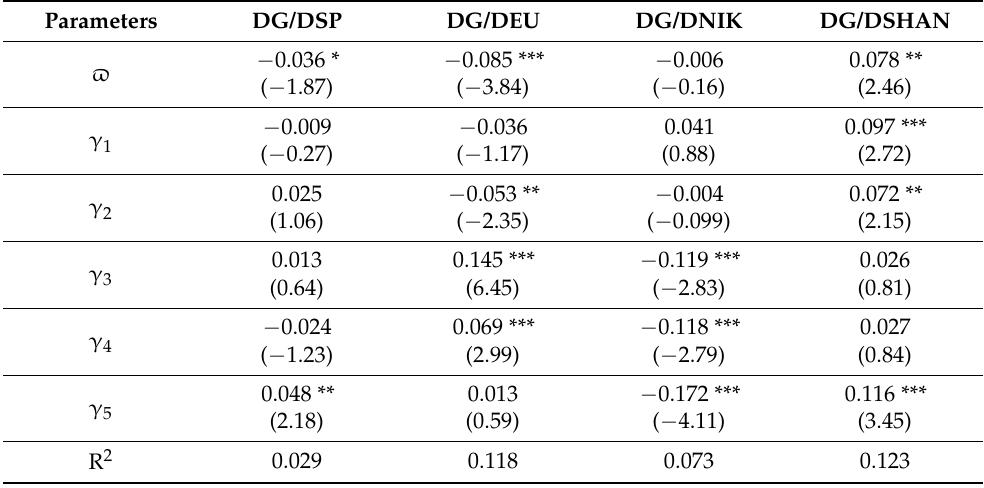
Table 5. Impact of Financial Crises on Dynamic Conditional Correlations between Gold Returns and Stock Returns. Sample 2000M11–2019M3 (221 Obs.). Parameters DG/DSP DG/DEU